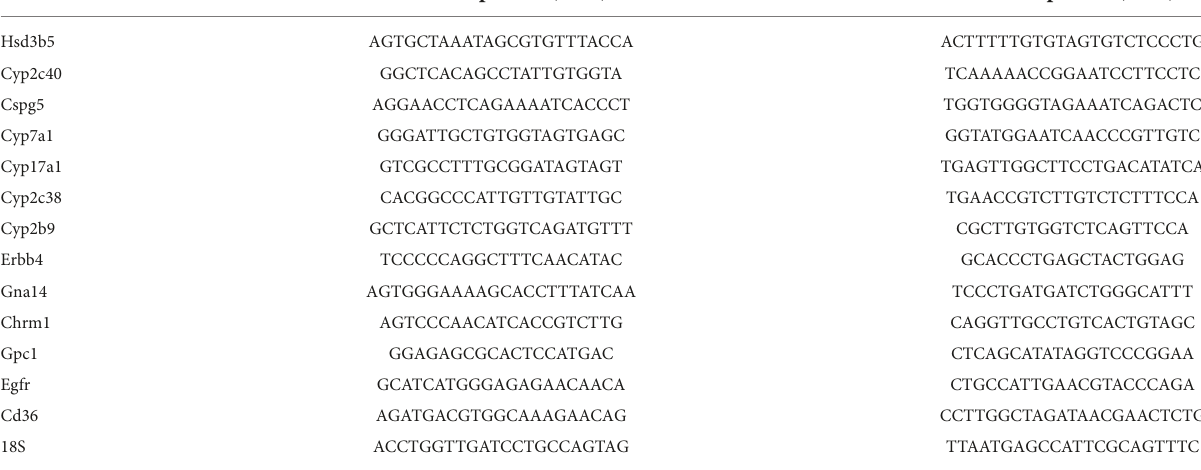
TABLE 1 Sequence of primers used for qPCR.